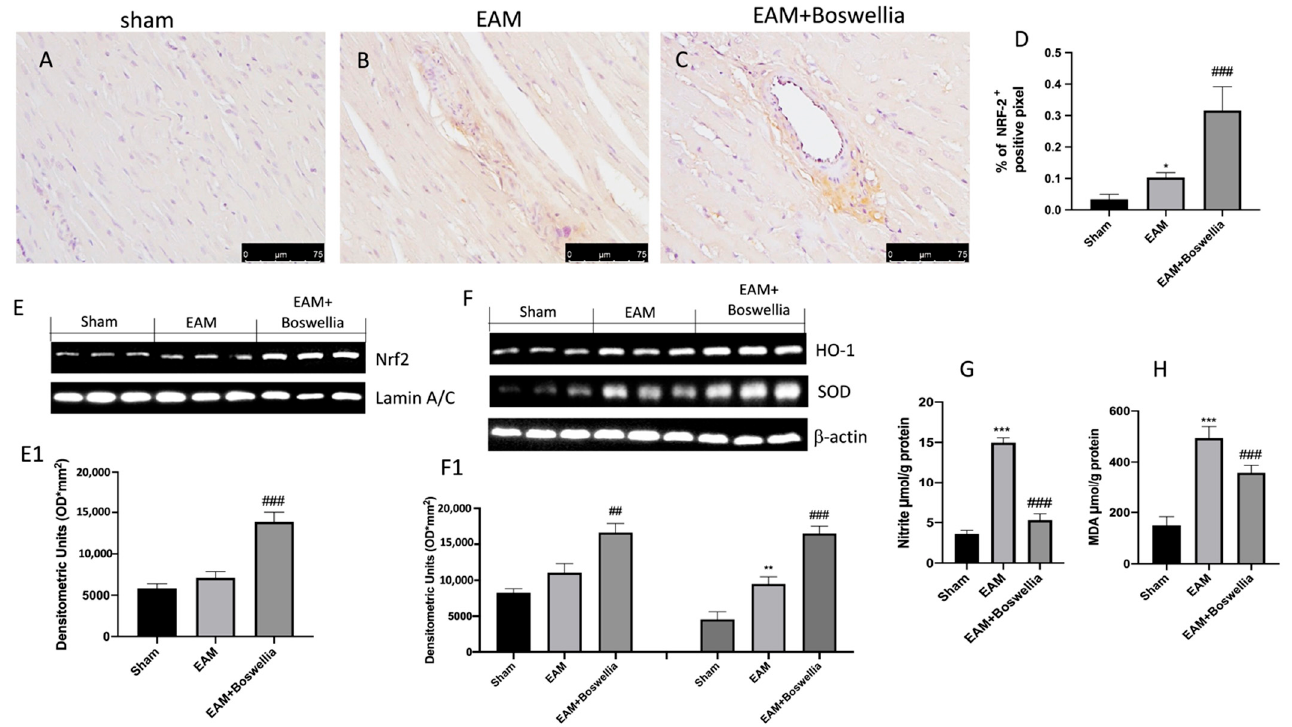
Figure 8. Effect of Boswellia extract on NRF-2 pathway and evaluation of NO release and MDA levels. NRF-2 immunohistochemistry for ( A ) sham group, ( B ), EAM + vehicle group, ( C ) EAM + Boswellia gum extract. The result is expressed as % of positive pixels ( D ). Scale bar: 75 μ m. Magnification (40×). Western blot for NRF-2 ( E , E1 ), HO-1 and SOD ( F , F1 ). Exposed is a characteristic blot of lysates from 6 animals/set, together with a densitometric evaluation for all ( E1 , F1 ). Nitrite levels ( G ), MDA levels ( H ). Boswellia extract administration was able to activate NRF-2 pathway as well as reduce nitrite and MDA levels. Values = means ± SEM of 6 animals for each set. *** p < 0.001 vs. sham. ** p < 0.01 vs. sham. * p < 0.05 vs. sham ## p < 0.01 vs. EAM. ### p < 0.001 vs. EAM.